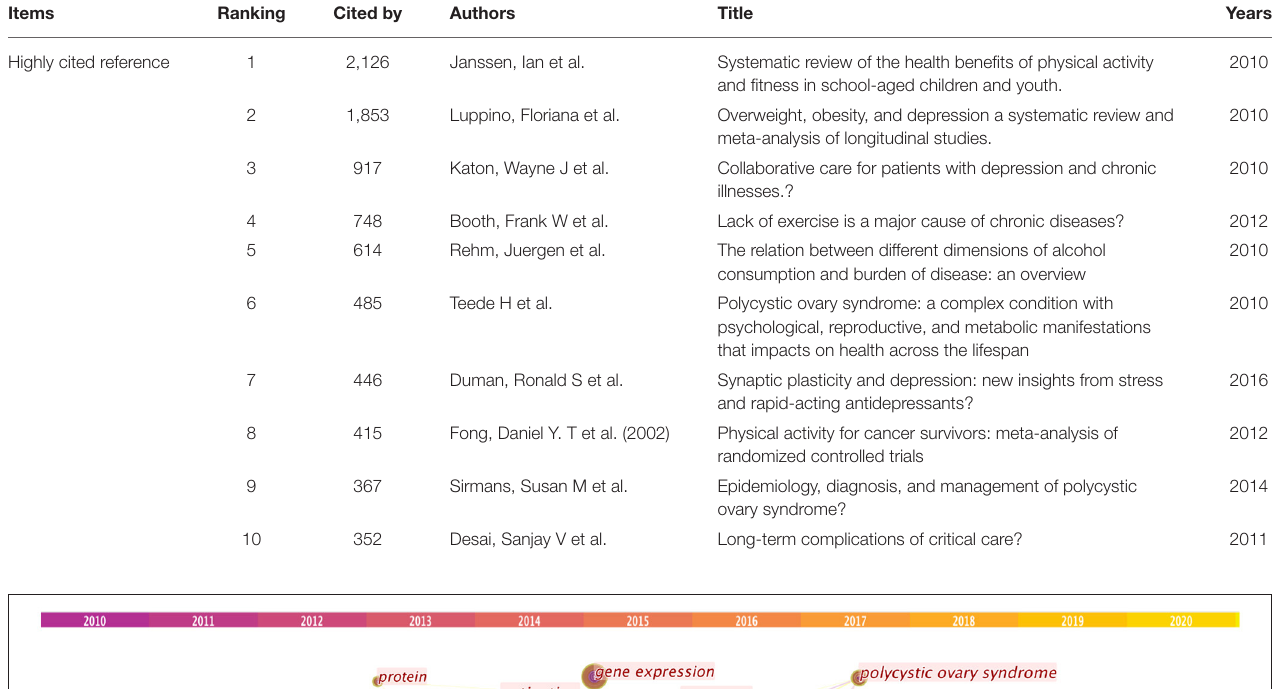
TABLE 3 | The top 10 highly cited references.